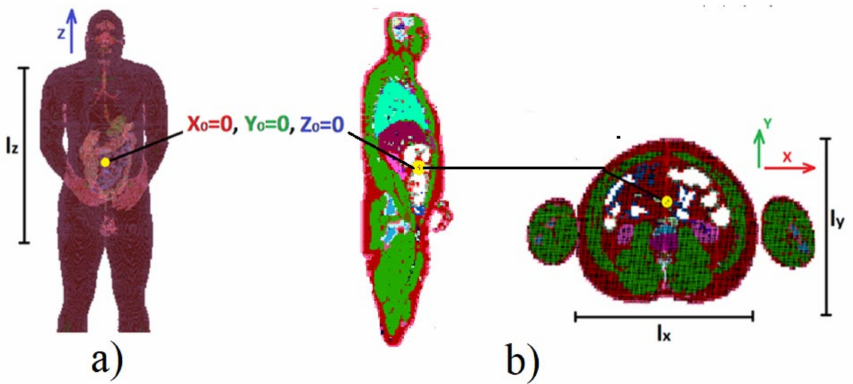
Figure 4. Numerical model used in simulations: ( a ) front view, ( b ) cross-section in XY plane for z = Z 0 and for ZY for x = X 0